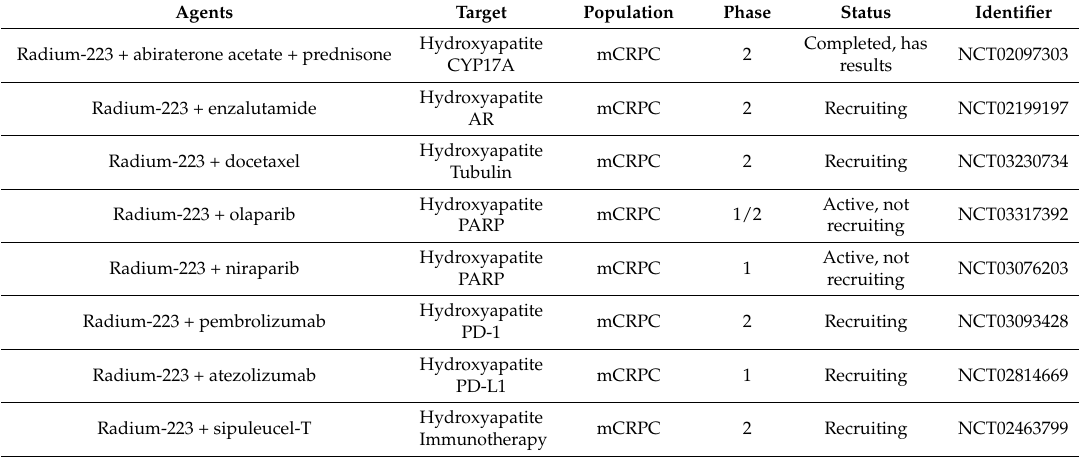
Table 4. Selected clinical studies with radium-223 dichloride and combination partners focusing on prostate cancer. Source: